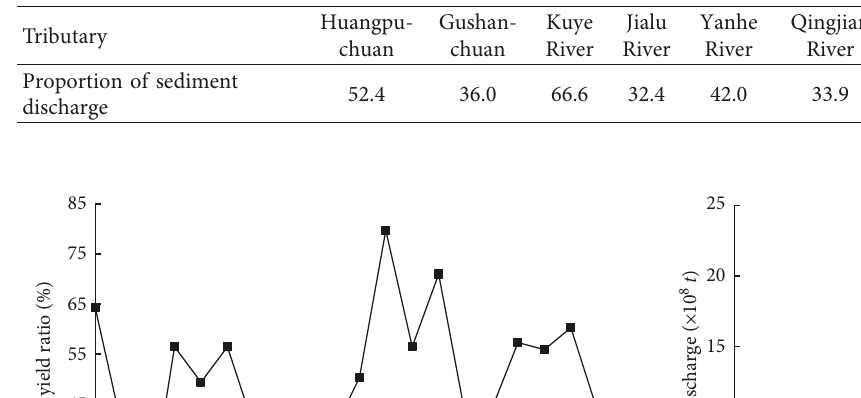
50 in typical tributaries (%).